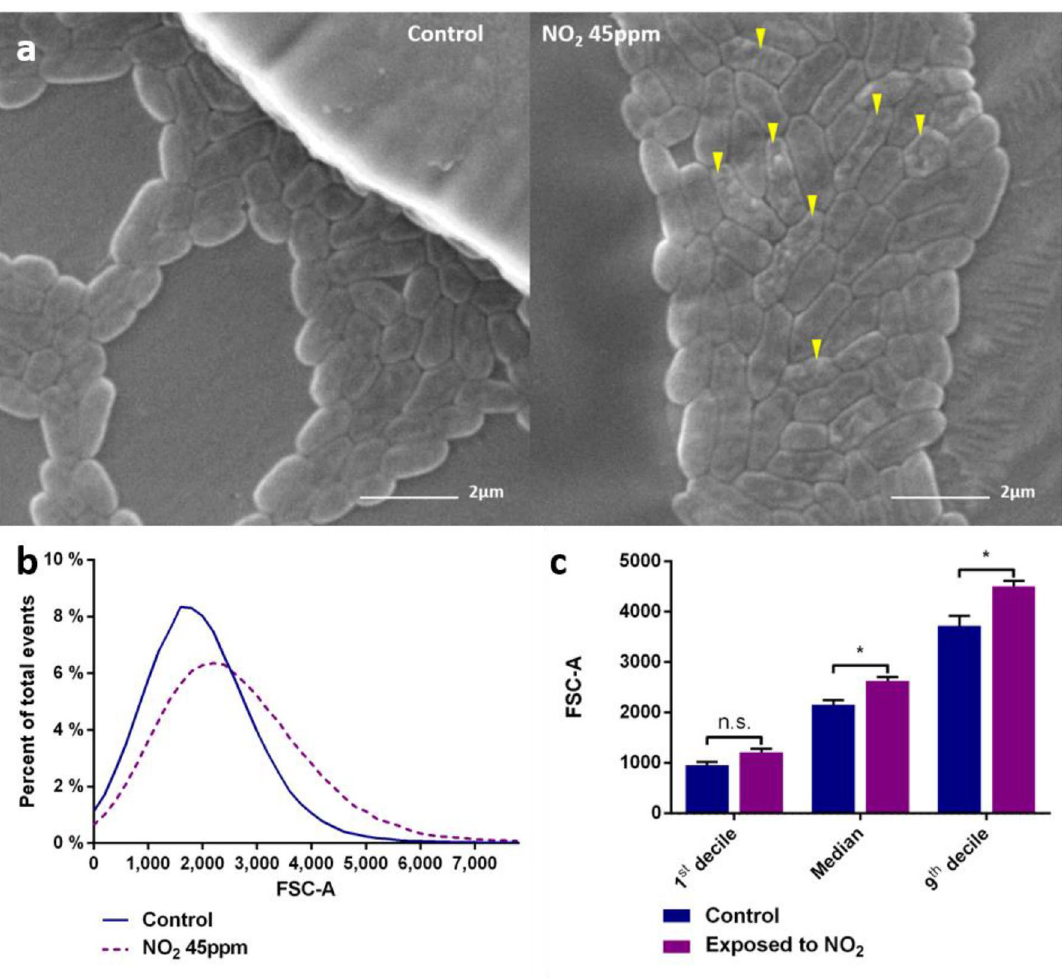
Figure 1. Morphology of P.fluorescens MFAF76a after exposure to NO 2 45 ppm. ( a ) P. fluorescens MFAF76a strain observed by scanning electron microscopy. After exposure to either synthetic air (control) or 45 ppm of NO 2 (NO 2 45 ppm) for 2 h, P. fluorescens MFAF76a were fixed and observed by scanning electron microscopy, revealing envelope alterations (yellow arrows). ( b ) Forward scatter (FSC-A) curve of MFAF76a cells exposed to 45 ppm of NO 2 (NO2 45 ppm) or synthetic air (Control). ( c ) Forward scatter (FSC-A) of the 1st, 5th and 9th deciles of MFAF76a cells exposed to 45 ppm of NO 2 or synthetic air. Statistical significance was determined using a Mann–Whitney test (N = 5). n.s. = p > 0.05 * = p <